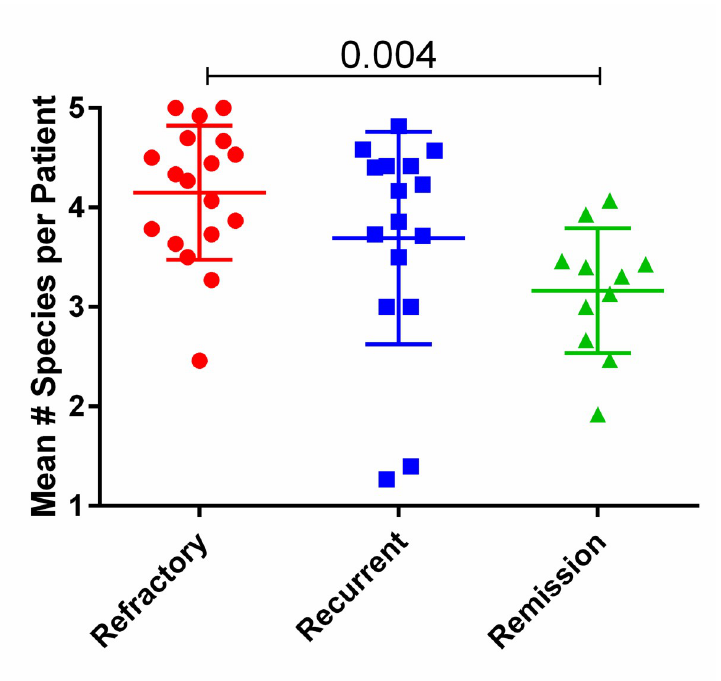
Fig 3. Number of Gardnerella species per patient. Each species was counted if present at a titer above 10x the limit of detection, then averaged for each patient over all days after initiation of oral metronidazole therapy. The p value was determined by Kruskal-Wallis test corrected for multiple